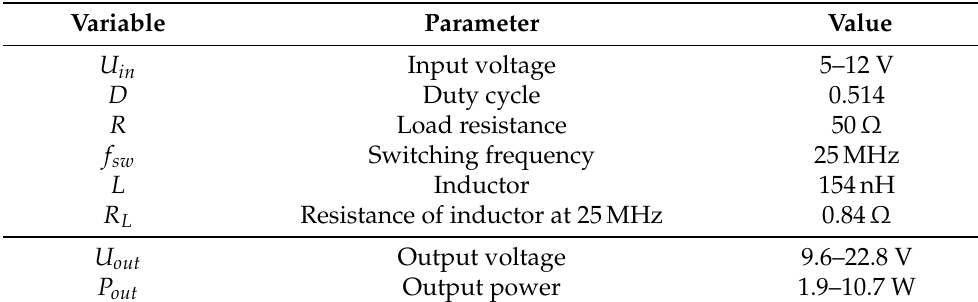
Table 2. Parameter of the designed boost converter.